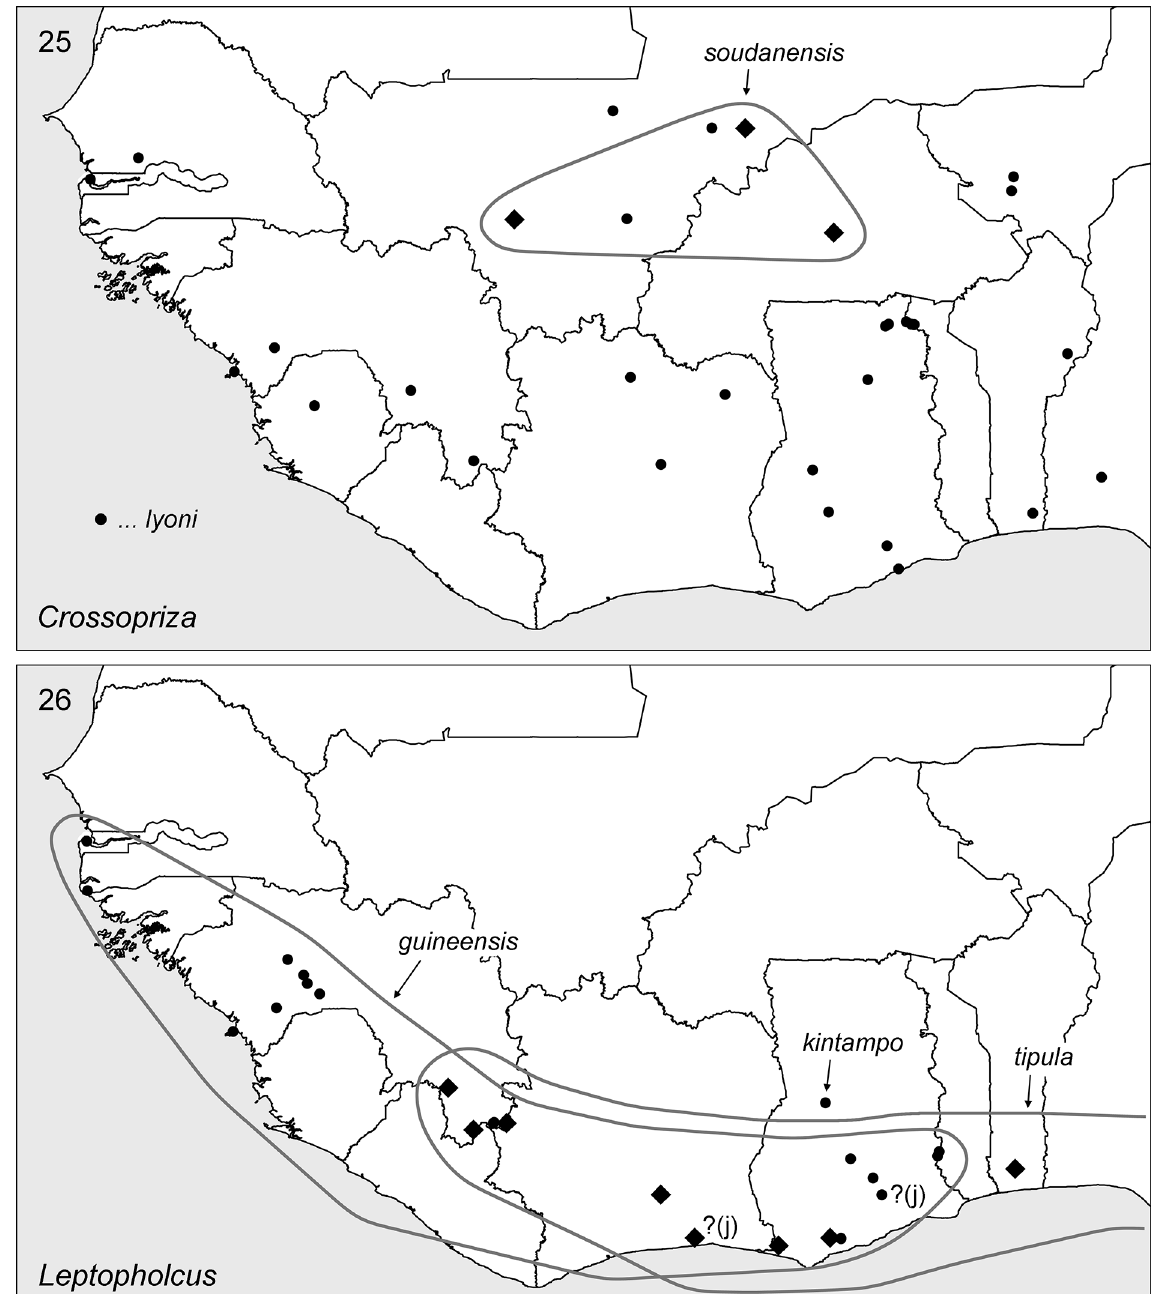
Figs 25-26. Known distributions of the genera Crossopriza Simon, 1893 and Leptopholcus Simon, 1893 in West Africa. Question marks denote uncertain identifications [“?(j)”: juveniles